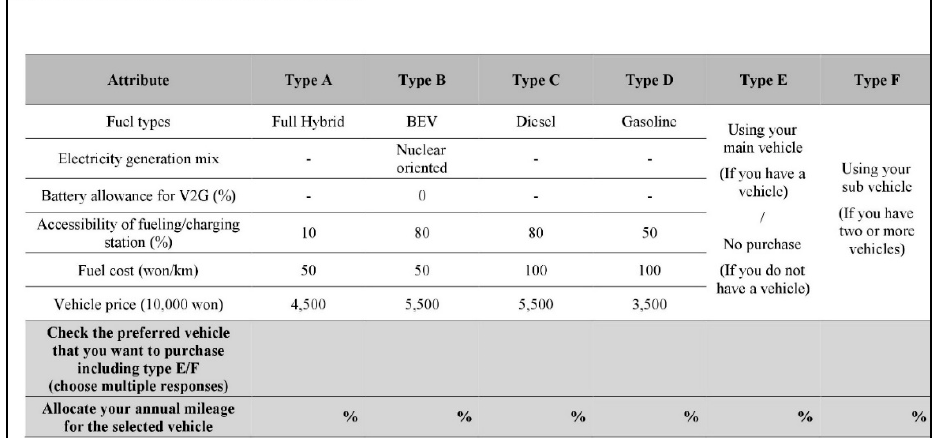
Figure 2. Sample of the conjoint survey.